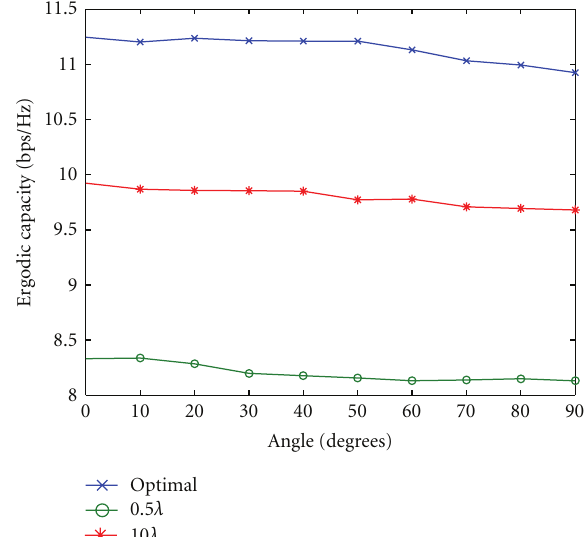
Figure 7: Ergodic capacity as a function of the angle deviation from the optimum angle ( ρ = 20 dB).